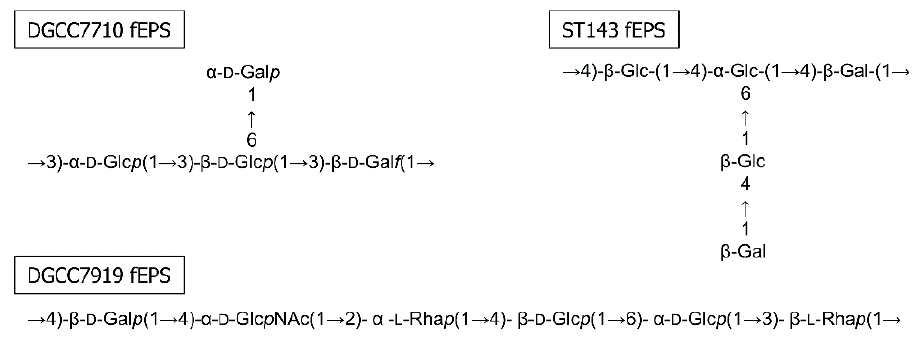
Figure 5. EPS structures of DGCC7710 fEPS [37], ST143 fEPS [49] and DGCC7919 fEPS [38].